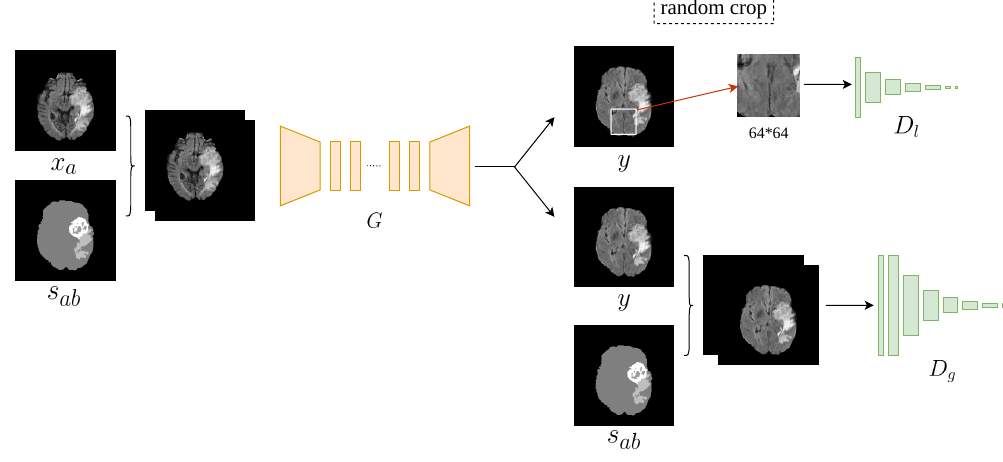
Figure 6. Details of the generator and discriminator structures. D g is the global discriminator and D l is the local discriminator. The input of D l is a randomly cropped section of y